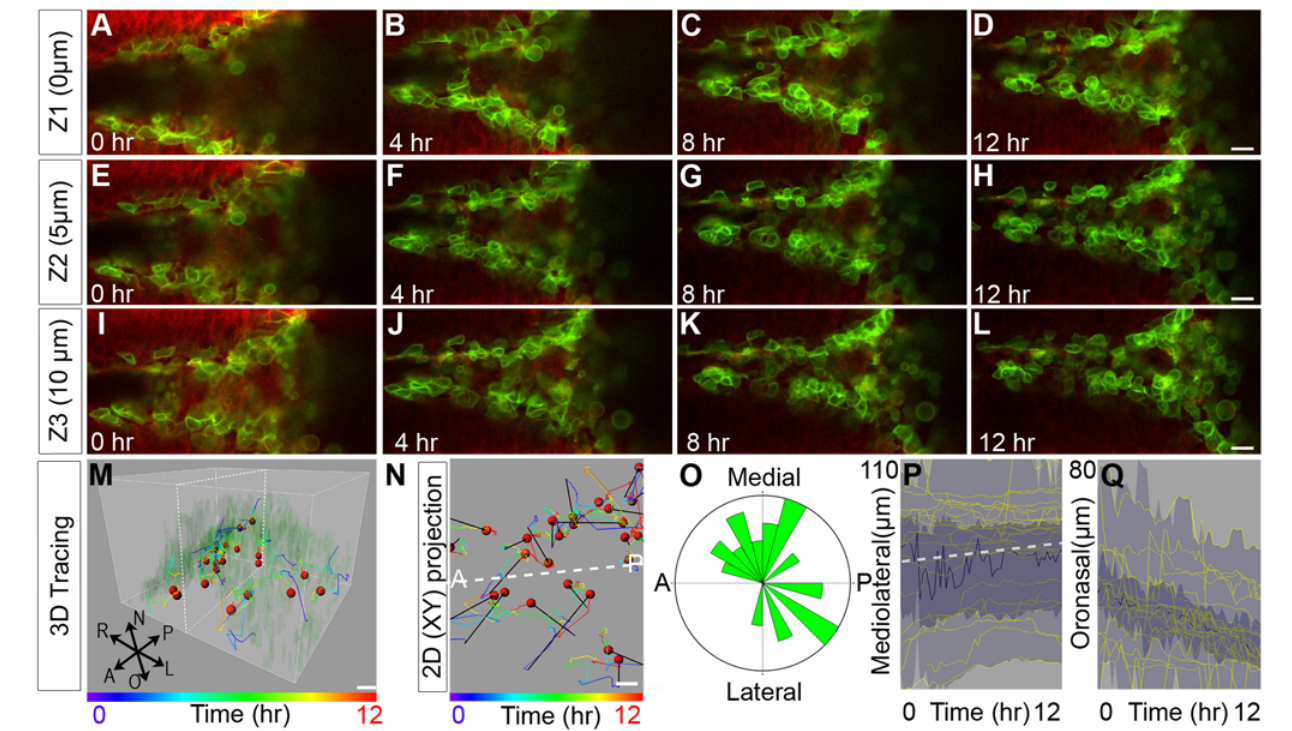
Fig 4. Confocal live imaging reveals a requirement for ROCK in MES intercalation and oral displacement. (A – L) Live confocal imaging of K14-Cre; ROSA26 mTmG/+ palatal explant cultures in the presence of 10 μ M Y27632 at three different optical depths revealed defective convergence and no intercalation, with multiple layers of MES maintained after 12 h of culture. Scale bar, 20 μ m. (M – N) 3-D (M) and 2-D (N) tracking shows considerably reduced oral displacement of the epithelium concomitant with failed convergence, though some random XY migration of MES cells was observed. Scale bar, 10 μ m. Dashed white lines in M, N indicate the plane of the MES. (O) Rose diagram of angles of displacement of epithelial cells in explant culture treated with 10 μ M Y27632. (P) Vantage plot of mediolateral position over time indicates that ROCK inhibition causes defects in cell convergence to the midline. (Q) Vantage plot of oronasal position over time indicates reduced oral displacement of MES cells. In (P, Q), the yellow lines are individual cell positions, the thick blue line is the median of the cell movements, the dark blue area is a range between the lower quartile and upper quartile, and light blue indicates the maximum range for 39 cells. Please see S1 Data for raw